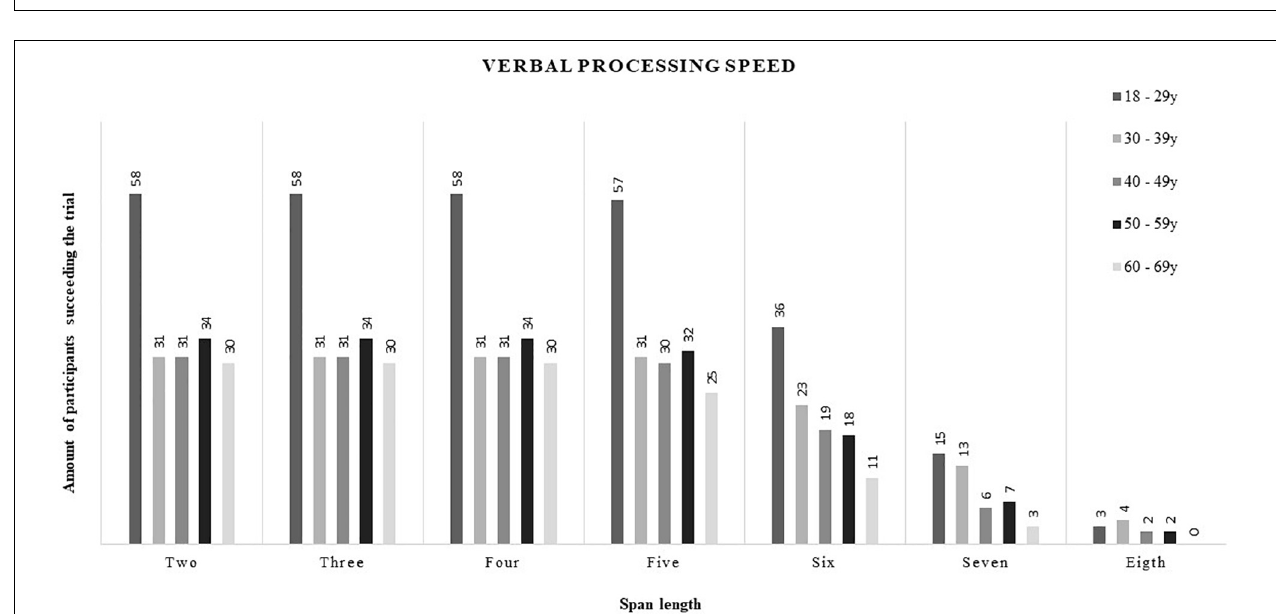
FIGURE 2 | Verbal processing